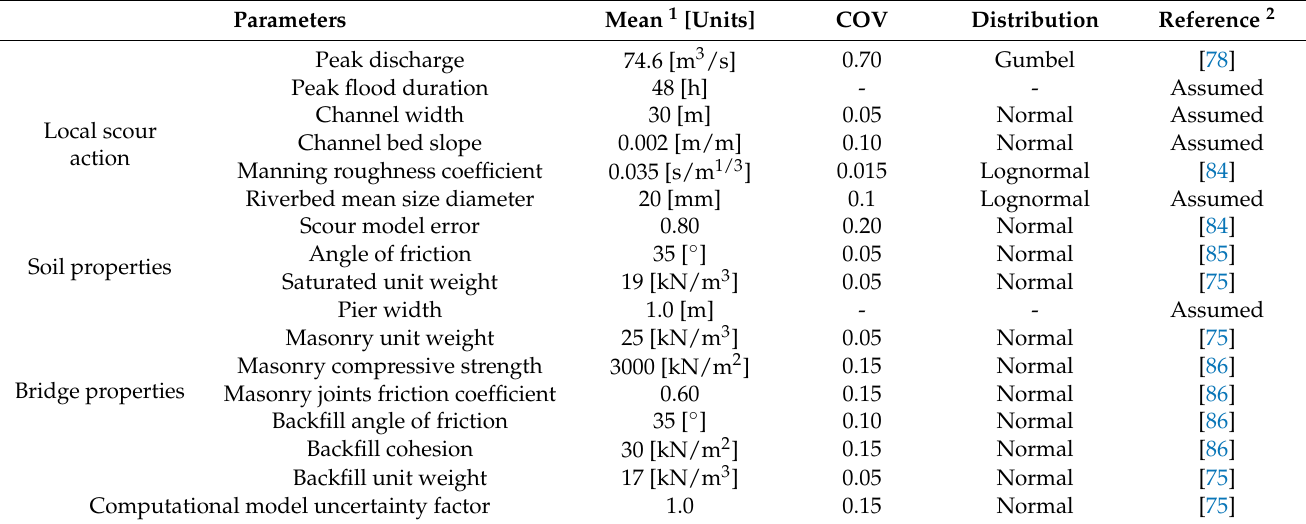
Table 5. Statistical properties of